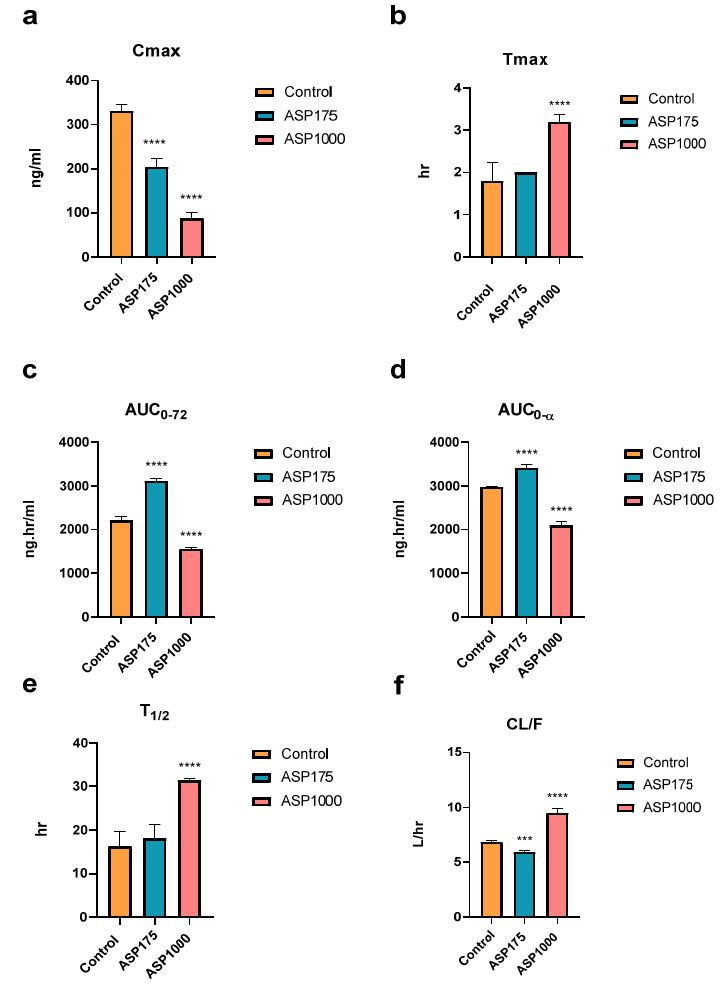
Figure 2. ( a – f ) Alteration in the main PK parameters ( a ) Cmax, ( b ) Tmax, ( C ) AUC 0-72 , ( d )AUC 0- α , ( e ) T 1/2 , ( f ) CL/F of ERL of GEF after four weeks administration of 1000 and 175 mg/kg ASP in rats compared to control ( n = 5). p -values of 0.05 were considered statistically significance, where *** p < 0.001, and **** p < 0.0001.